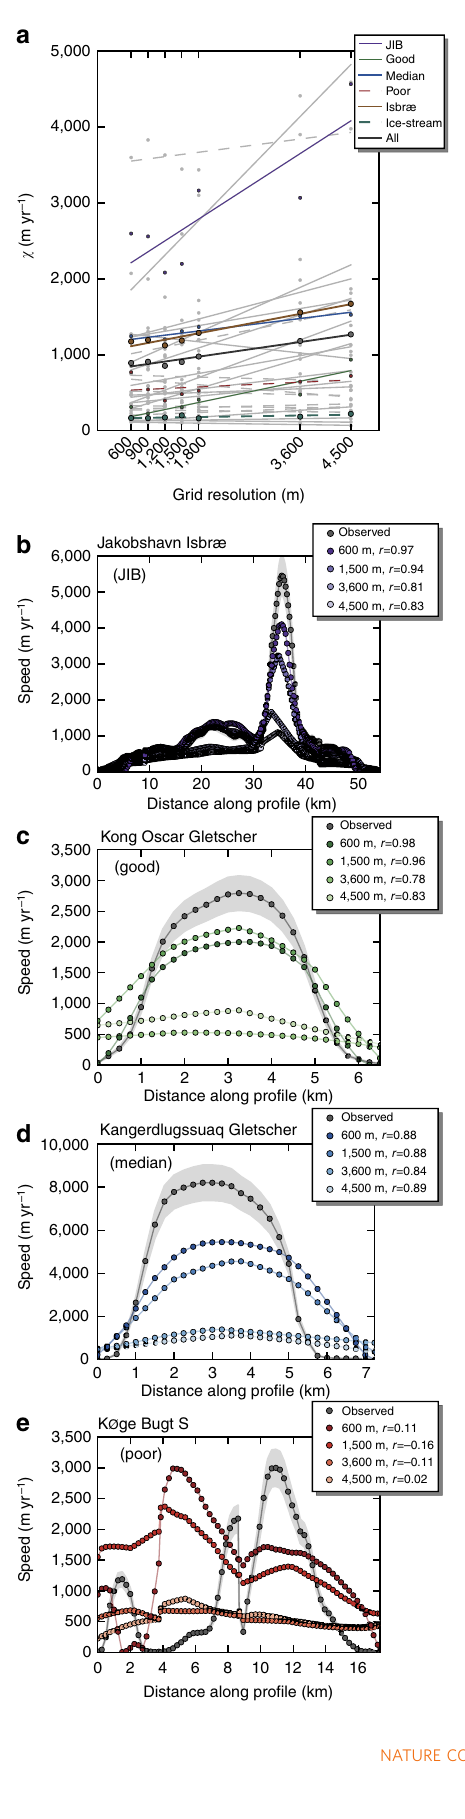
Figure 2 | Outlet glacier profiles as a function of grid resolution. ( a ) Linear regression analysis of the root mean square (r.m.s.) difference w under grid refinement. Dots mark total w , and solid and dashed lines indicate statistically significant and not significant trends, respectively. Also, the trends of all glaciers, all ‘isbræ’-type, and all ‘ice-stream’ type glaciers are shown. ( b – e ) Four examples of observed and simulated surface velocity cross profiles, evaluated every 250m along profiles using bilinear interpolation; Jakobshavn Isbrae (JIB) ( b ), a glacier that has a high correlation coefficient (Kong Oscar Gletscher) ( c ), the glacier whose correlation coefficient represents the sample median (Kangerdlugssuaq Gletscher) ( d ) and a glacier with a poor fit (Køge Bugt S) ( e ). The shaded grey area indicates observational